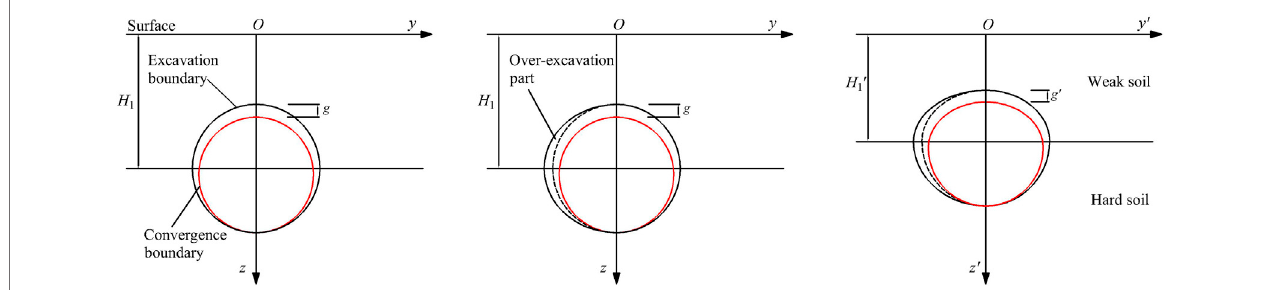
FIGURE 6 | Transformation model between excavation boundary and convergence boundary of curved